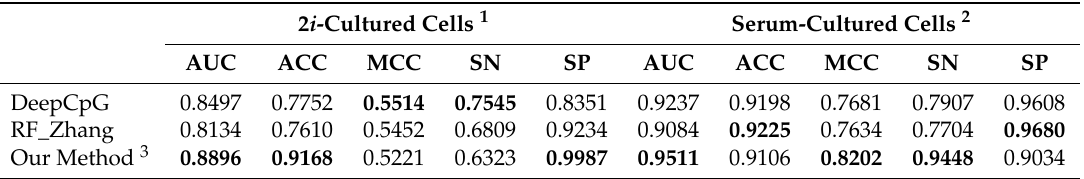
Table 4. Comparison of our method, DeepCpG, and RF_Zhang on scBS-seq profiled